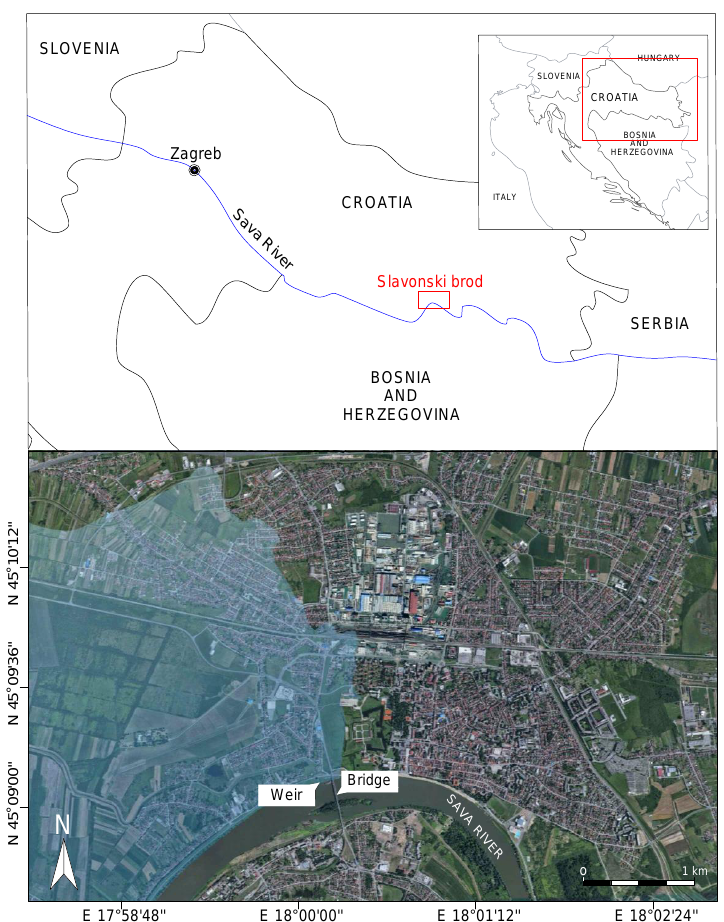
Figure 1. Estimated flooded area of city of Slavonski Brod during the flood event in the Sava River in 2014.